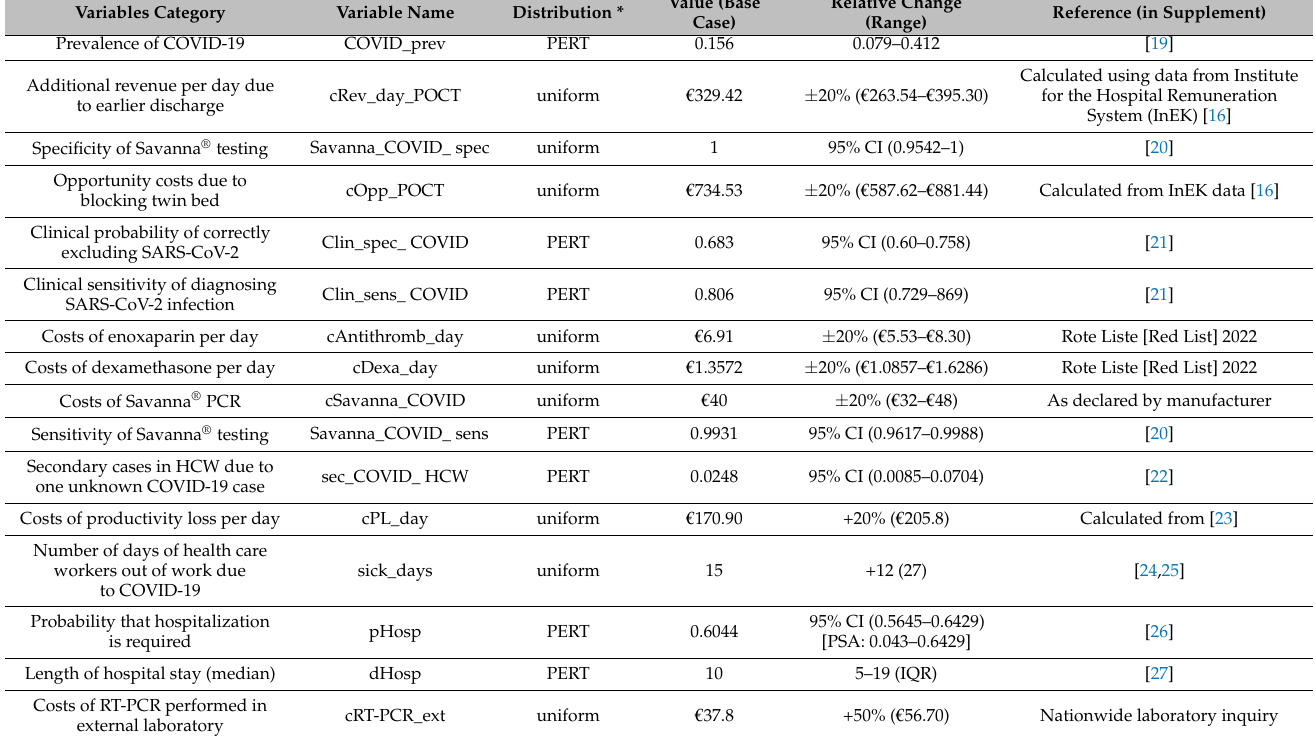
Table 1. Input for cost–benefit analysis.